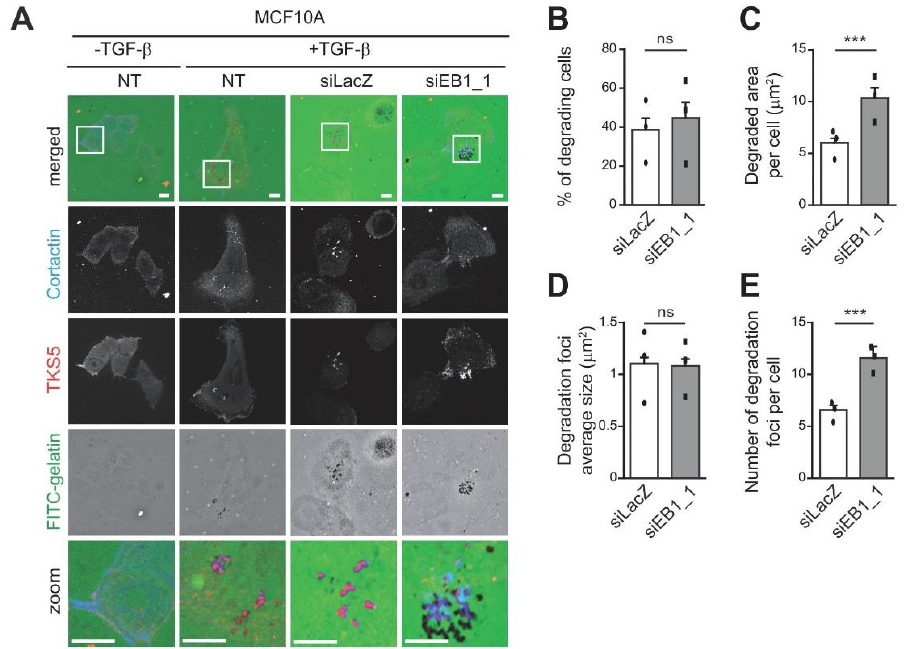
Figure 2. EB1 restricts ECM degradation via inhibition of invadopodia formation in TGF-β-transformed MCF10A breast epithelial cells. Non-transfected (NT) MCF10A cells or cells transfected with a control siRNA (siLacZ) or a siRNA against EB1 (siEB1_1) were treated or not with TGF-β for 6 days before seeding on FITC-gelatin for 4 h. Invadopodia and matrix degradation were identified as described in Figure 1. ( A ) Representative images are shown. The white-boxed regions are enlarged at the bottom (zoom). Scale bars represent 10 μm in non-enlarged images, 5 μm in enlarged images. ( B – E ) The ability of MCF10A cells to degrade fluorescently-labeled gelatin was analyzed. The percentage of degrading cells ( B ), the degraded area per cell ( C ), the average size of degradation foci ( D ), and the number of degradation foci ( E ) are represented as the mean ± SEM of three independent experiments. The mean of each individual experiment is reported. Statistical analysis was performed as described in Figure 1. *** p ≤ 0.001, ns not significant.